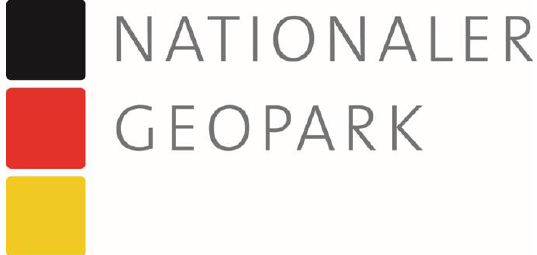
Figure 1. Germany’s “National GeoPark” logo (Source: GeoUnion Alfred-Wegener-Stiftung). Sixteen geoparks were awarded the label “National GeoPark” in Germany